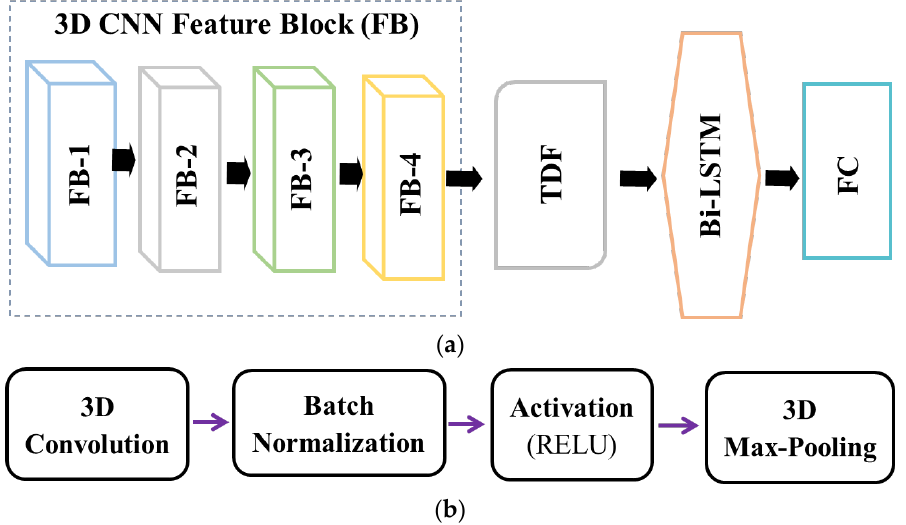
Figure 5. Deep learning architecture for proposed REIS. ( a ) Basic building block structure of the proposed DL architecture; ( b ) Structure of a convolutional feature block. Table 1. The layer parameters of the proposed 3D CNN Bi-LSTM architecture. Feature Block